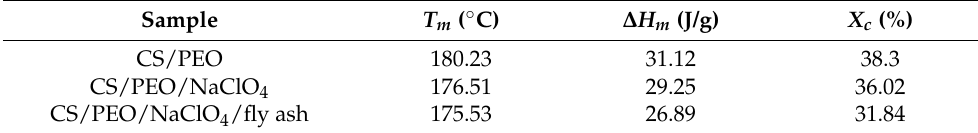
Table 3. Melting point enthalpy ( ∆ H m ) and crystallinity degree of SPE.